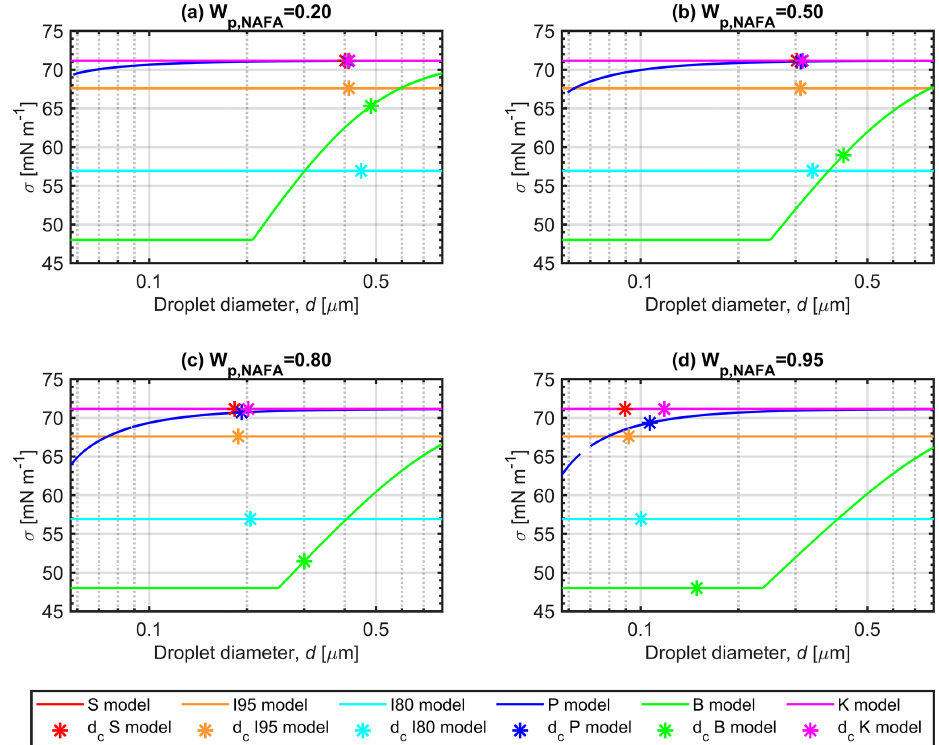
Figure 4. Surface tension along Köhler curves for growing aqueous NAFA–NaCl droplets formed from 50nm dry particles with NAFA mass fractions of (a) 0.20, (b) 0.50, (c) 0.80, and (d) 0.95, calculated with the different models described in Sect. 2.4. The critical points of droplet activation (corresponding to SS c presented in Figs. 1 and S1) are indicated with asterisks on each surface tension